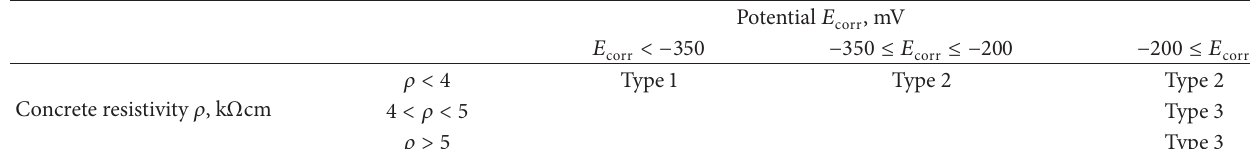
Table 6: Proposed types of corrosion probability.